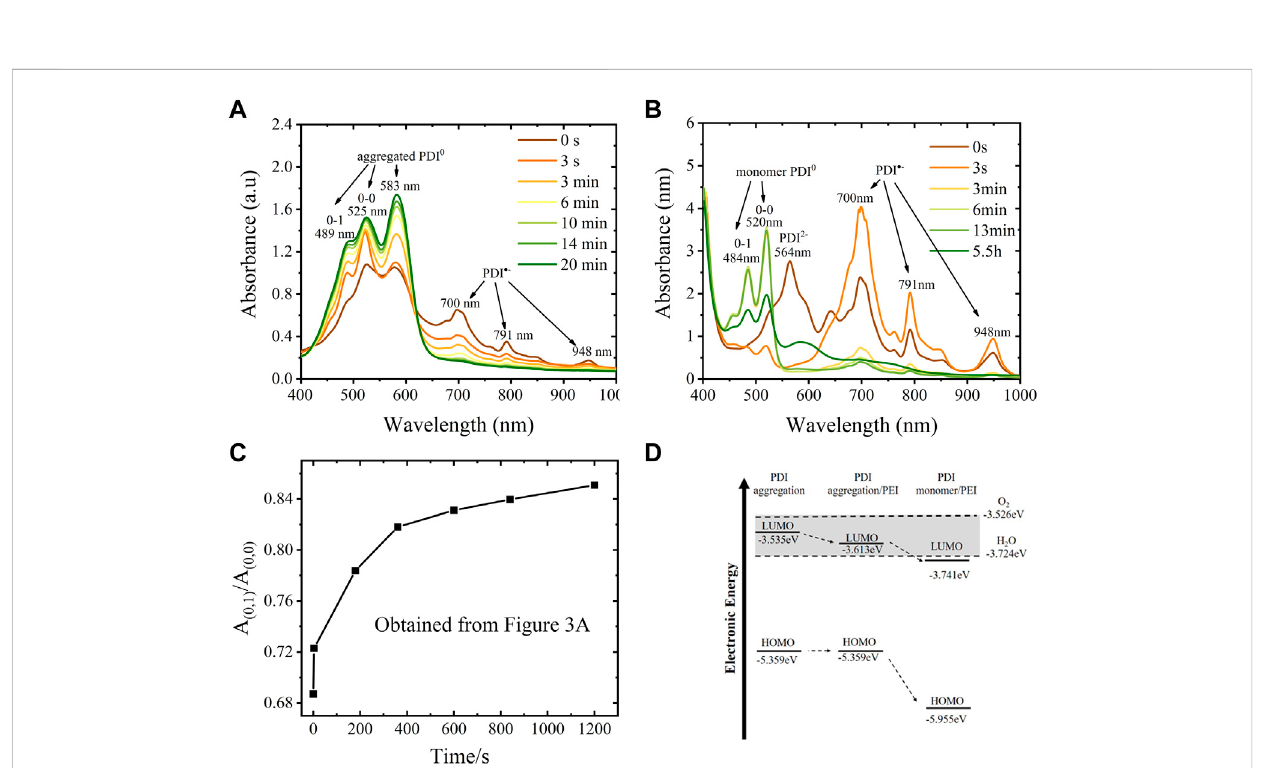
FIGURE 3 Stability of PDI radical anion and dianion using hydrazine hydrate and PEI as a dopant. (A) UV-vis spectra of hydrazine hydrate reduced PDI suspension that exposure to air or different time, 50 µL of the reduced suspension(10 mg/mL) was dropped cast on a clean glass substrate and dried at 120 ° C for 3 hours and then kept at 50 ° C overnight to remove excess hydrazine hydrate, then the dry fi lm was scraped to dissolve in 5 ml DMF with a dropper in the glovebox before UV-vis spectroscopy, PDI concentration in DMF is ~0.1 mg/mL; (B) UV-vis spectra of PEI reduced PDI suspension that exposure to air for a different time; (C) A plot of A 0 – 1 /A 0 – 0 ratio as a function of time exposed to air, the data were obtained from Figure 3A; (D) DiagramofthecalculatedHOMOandLUMOenergyofPDImonomerinDMFwithorwithoutPEI.ThedashedlinesaretheLUMOenergylevelsofoxygen and